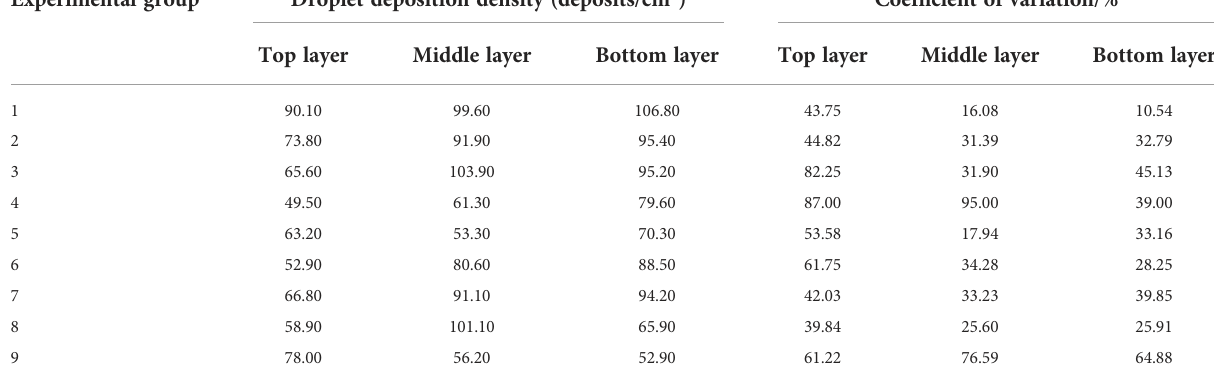
TABLE 5 Results of vertical longitudinal droplet deposition distribution in the